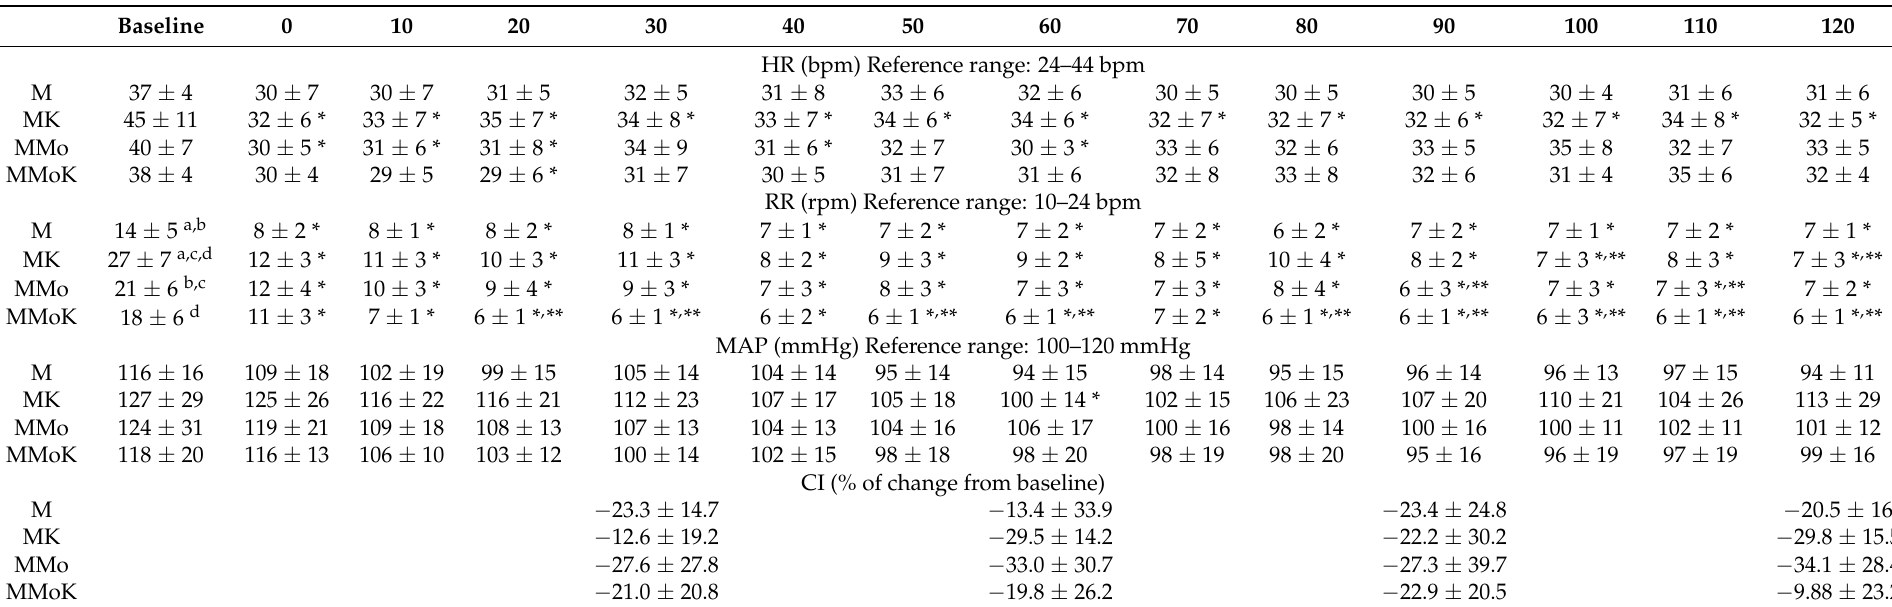
Table 2. Heart rate (HR), respiratory rate (RR), mean arterial pressure (MAP) and cardiac index (CI) before administration of any drug (baseline), and during the infusion in the four treatment groups. * Significantly different ( p < 0.05) from baseline within a treatment. ** Significantly different ( p < 0.05) from time 0 within a treatment a,b,c,d Different superscript letters indicate significant differences ( p < 0.05) between treatments at this